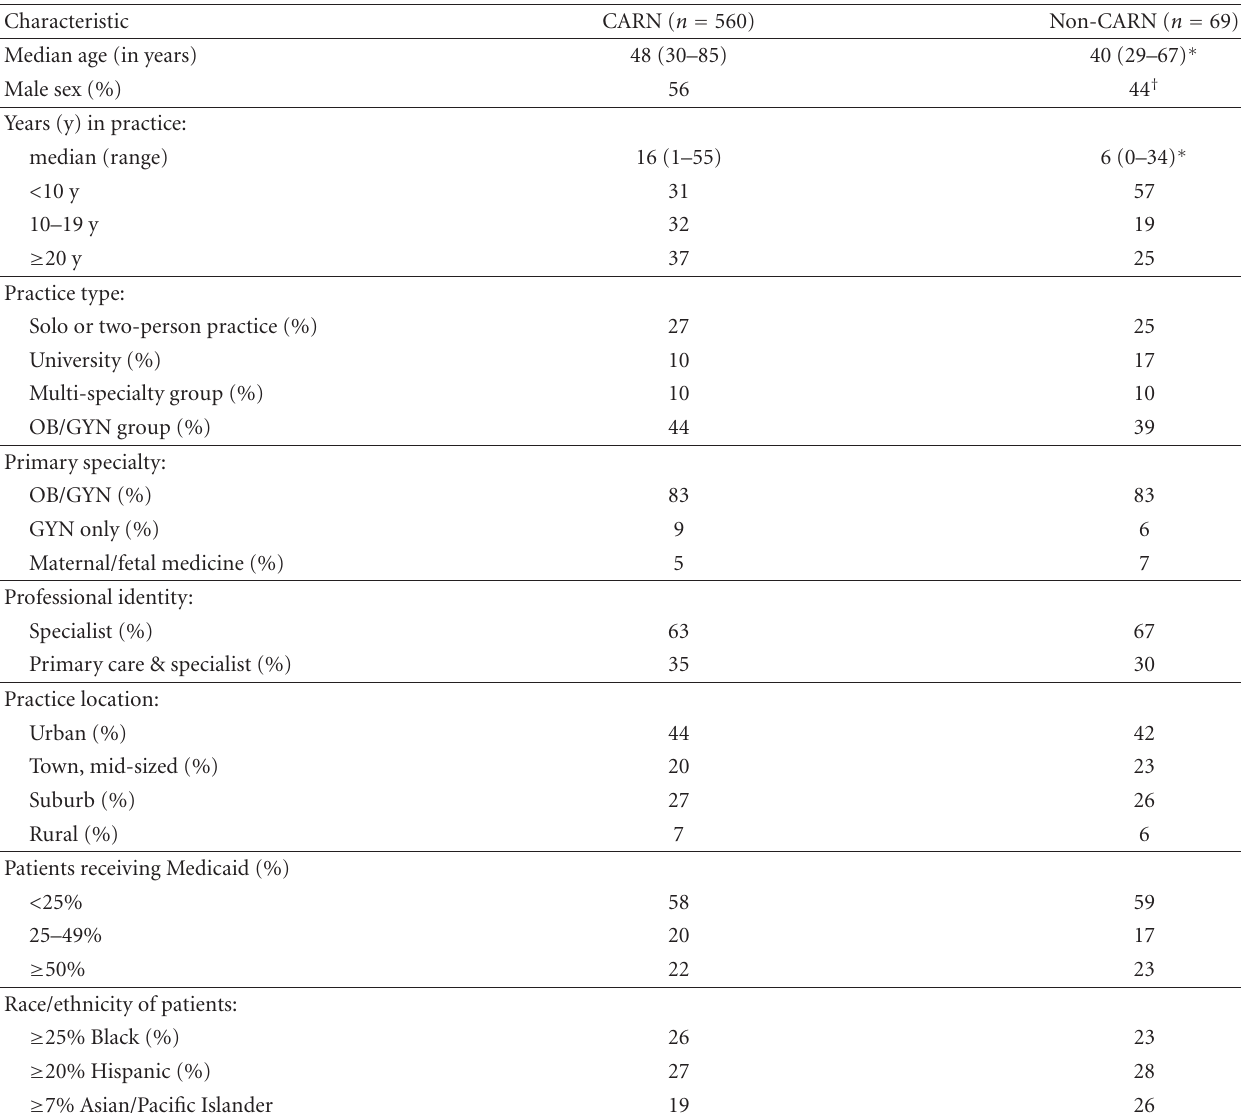
Table 1: Demographics and practice characteristics of survey respondents in the Collaborative Ambulatory Research Network (CARN) and non-CARN